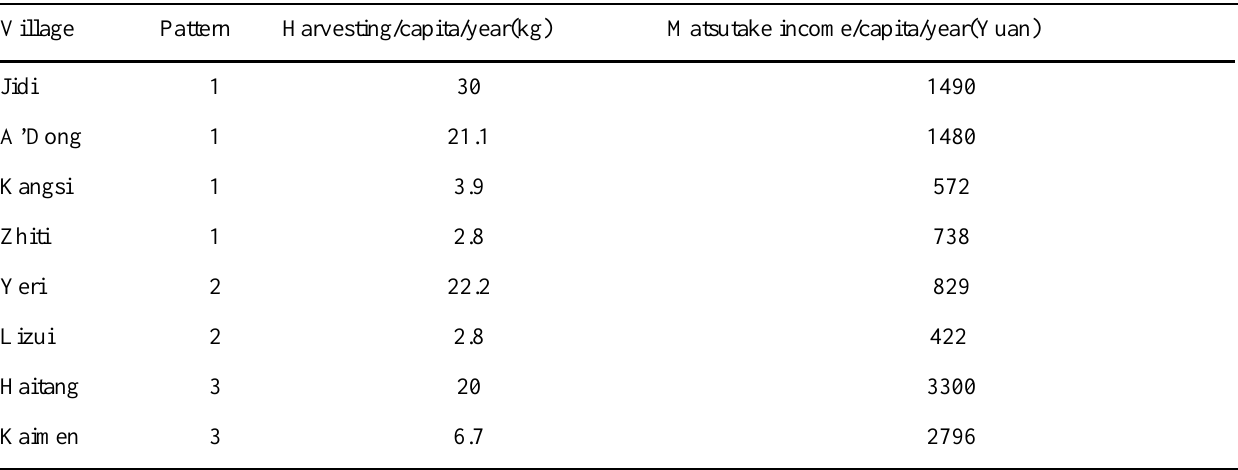
Table 4. Eight examples of matsutake production and income (US$1 = 6.8 CN Yuan).